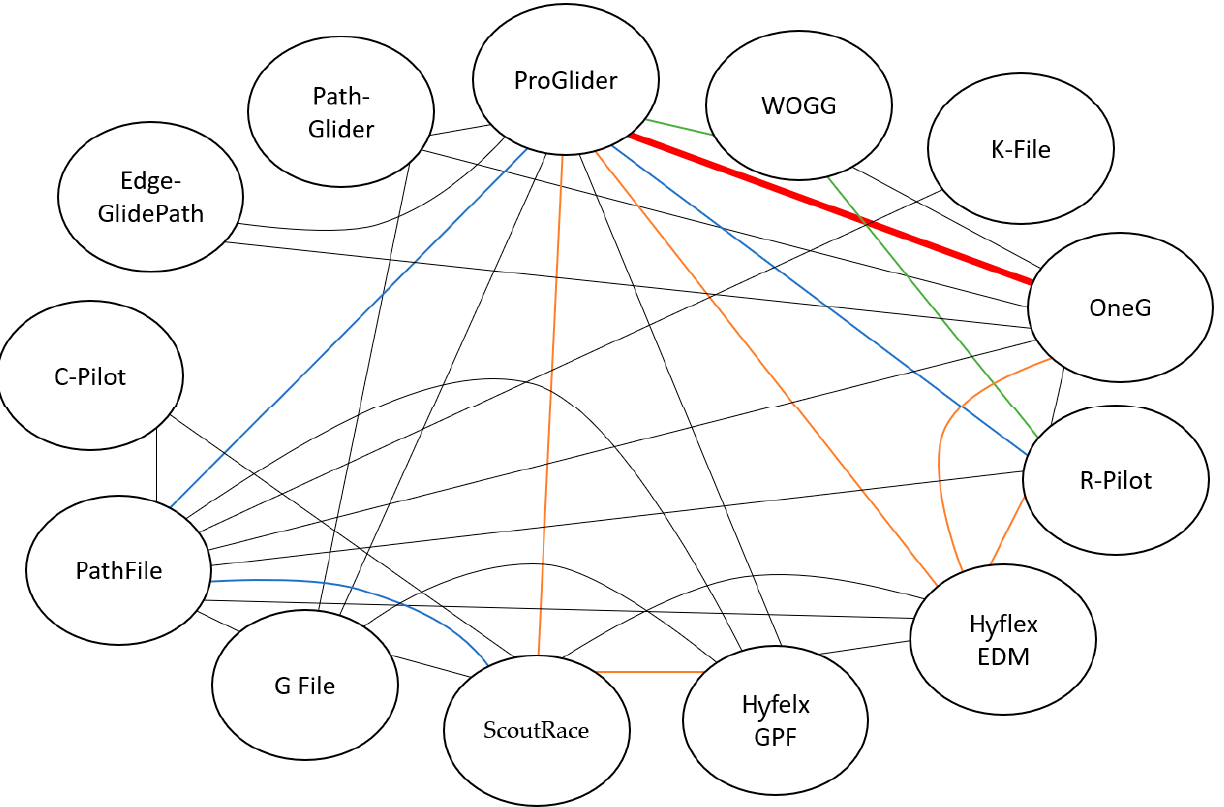
Figure 2. Schematic representation of the number of comparisons between files among the included studies. Color key: red (files are compared 6 times), green (files are compared 4 times), blue (files are compared 3 times), yellow (files are compared 2 times), and black (files are compared once).